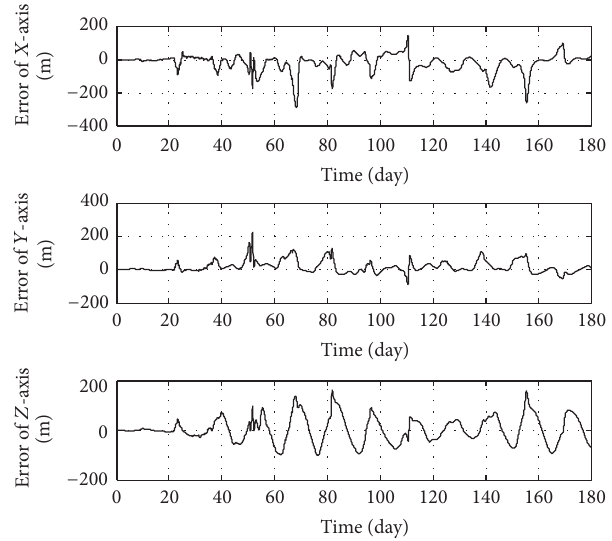
Figure 8: The AOD position error of 𝐿 2 using